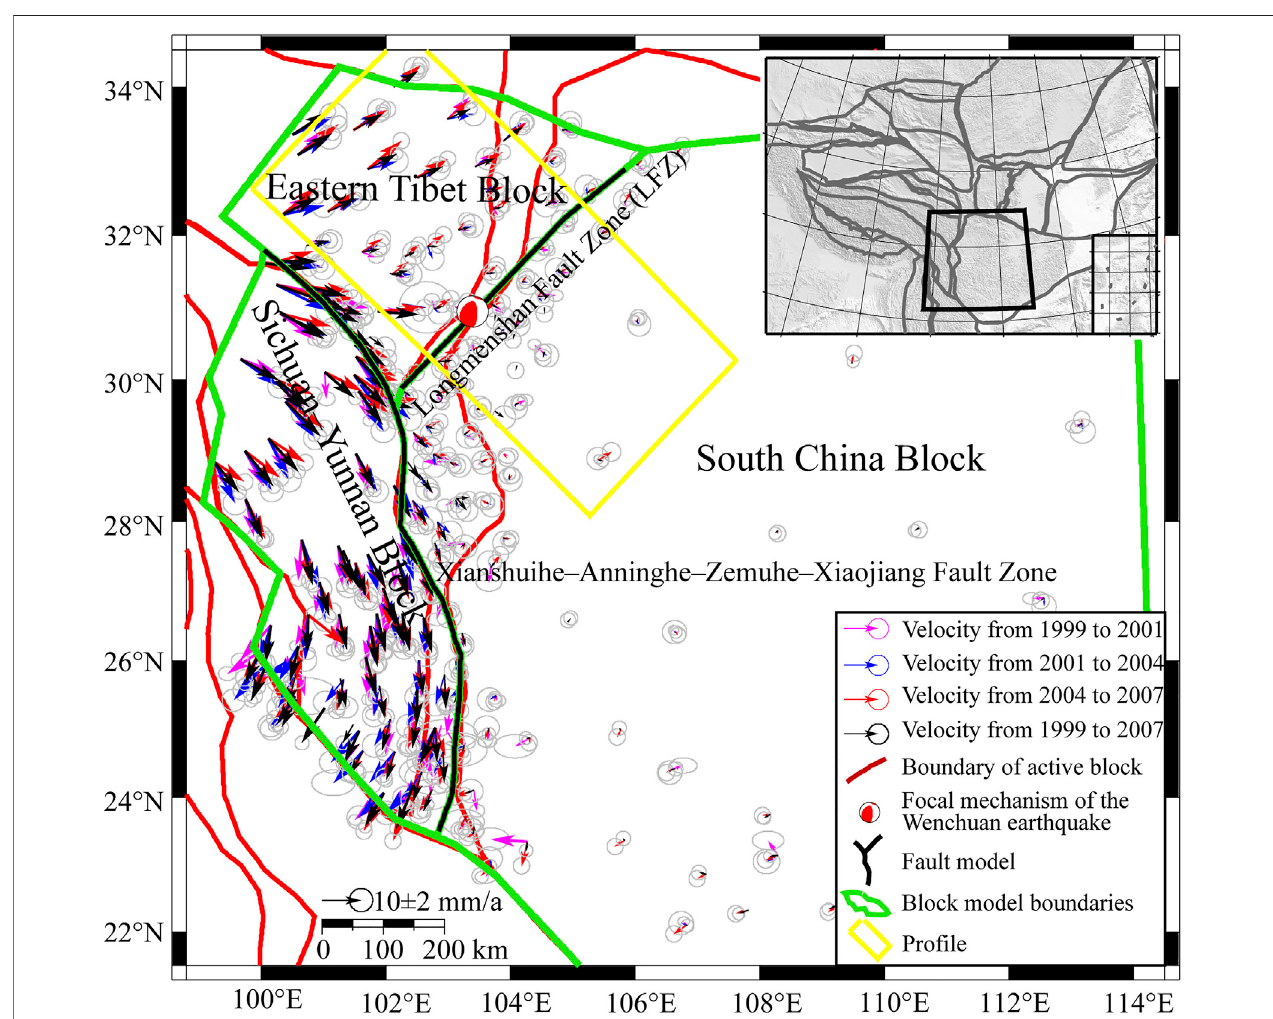
FIGURE1| GlobalPositioning System(GPS)velocity fi eldsofthestudyregionwithrespecttotheSouthChinaBlockduring1999 – 2001,2001 – 2004,2004 – 2007, and 1999 – 2007.ThegrayellipsesrepresenttheerrorsofGPSvelocity fi elds,anderrorellipsesrepresent 70%con fi dence.Theinsertmapshowstheregionalpositionof study area. The focal mechanism of the Wenchuan earthquake is derived from Global CMT Web Page (https://www.globalcmt.org/CMTsearch.html).